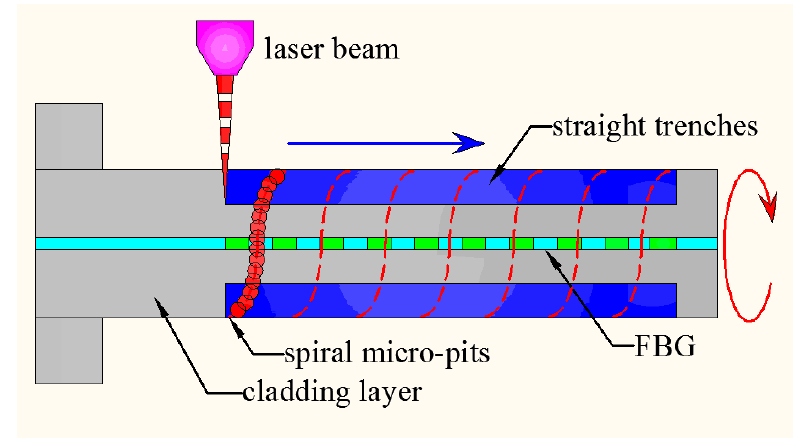
Figure 2. Schematic diagram for composite microstructure ablated by femtosecond laser.